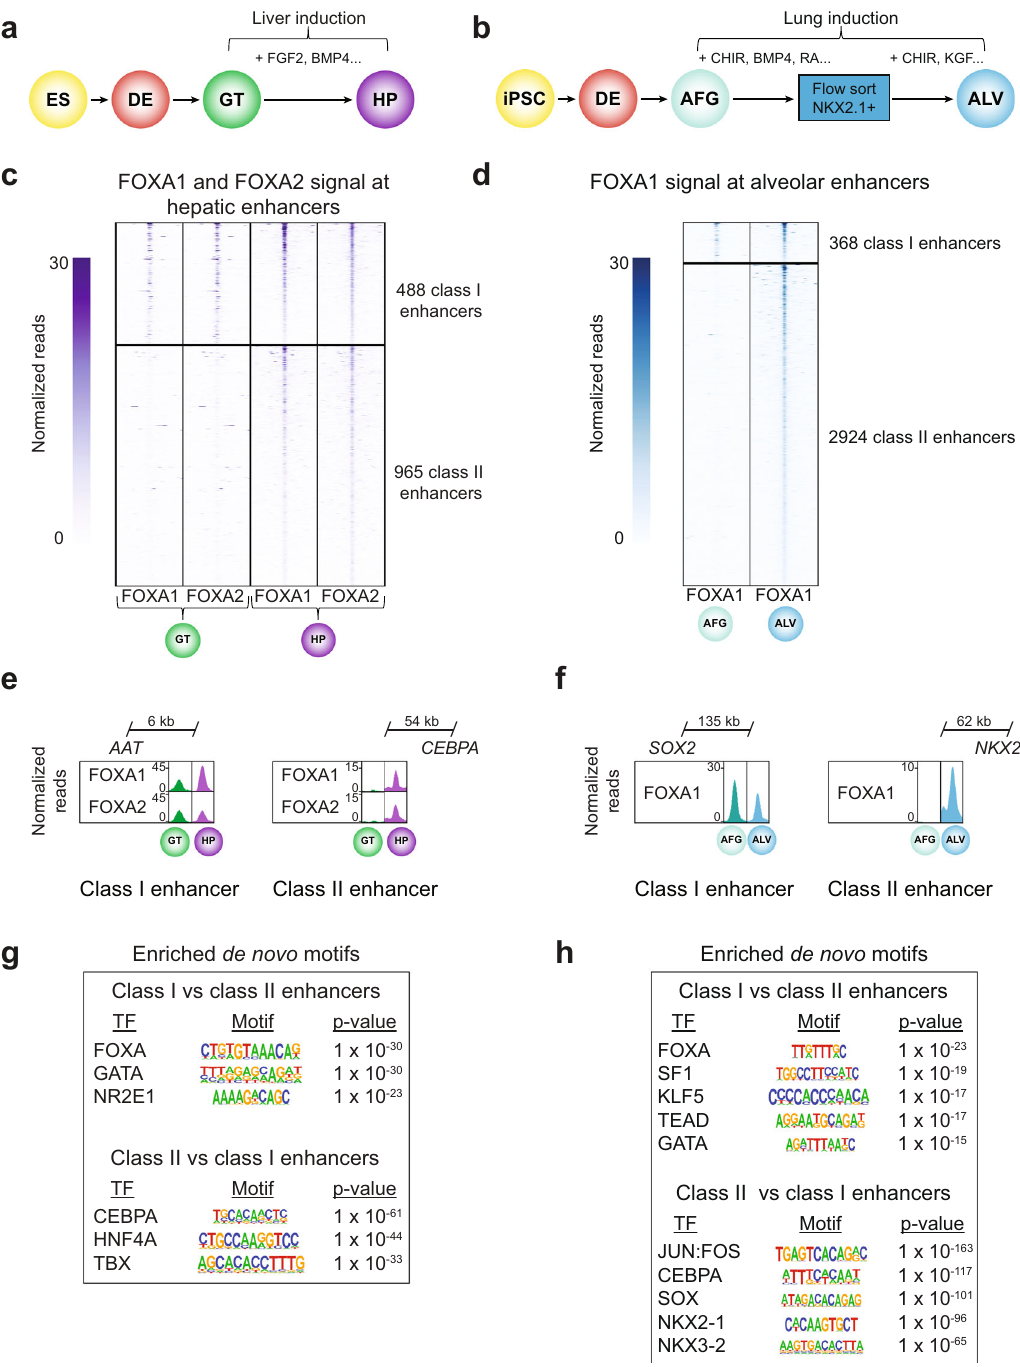
Fig. 7 Class I and class II enhancers can be distinguished in liver and lung development. a and b Schematic of stepwise differentiation of hESCs to hepatic progenitors (HP) ( a ) and induced human pluripotent stem cells (iPSC) into alveolosphere organoids (ALV) ( b ). AFG, anteriorized foregut. Select growth factors for hepatic ( a ) and alveolar ( b ) lineage induction are indicated. FGF2, fi broblast growth factor 2; BMP4, bone morphogenic protein 4; CHIR, CHIR99021; RA, retinoic acid. c Heatmap showing density of FOXA1 and FOXA2 ChIP-seq reads at hepatic enhancers in GT and HP. Heatmap is centered on FOXA1 and FOXA2 peaks, respectively, and spans 5 kb. Hepatic enhancers are classi fi ed based on temporal pattern of FOXA1 and FOXA2 occupancy. d Heatmap showing density of FOXA1 ChIP-seq reads at alveolar enhancers in AFG and ALV. Heatmap is centered on FOXA1 peaks and spans 5 kb. Alveolar enhancers are classi fi ed based on temporal pattern of FOXA1 occupancy. e Genome browser snapshots showing FOXA1 and FOXA2 ChIP-seq signal at a class I hepatic enhancer near AAT and a class II hepatic enhancer near CEBPA in GT and HP. f Genome browser snapshots showing FOXA1 ChIP-seq signal at a class I alveolar enhancer near SOX2 and a class II alveolar enhancer near NKX2.1 in AFG and ALV. g and h Enriched de novo transcription factor (TF)- binding motifs at class I against a background of class II enhancers and vice versa for hepatic ( g ) and alveolar enhancers ( h ). Fisher ’ s exact test, 1-sided, corrected for multiple comparisons. All ChIP-seq experiments, n = 2 replicates from independent